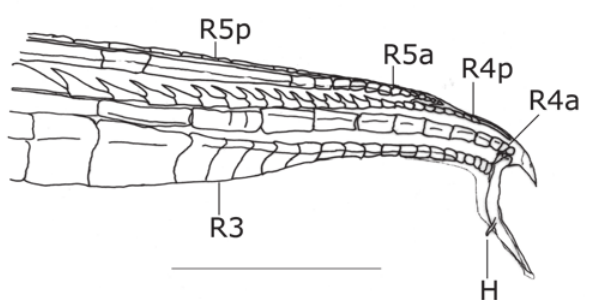
Fig. 17. Gonopodium tip of Phalloceros leptokeras , MCP 30512. (a) ventrolateral view; (b) lateral view. R3, R4a, R4p, R5a, R5p indicate gonopodial rays. H = hook. Scale bar 1 mm.